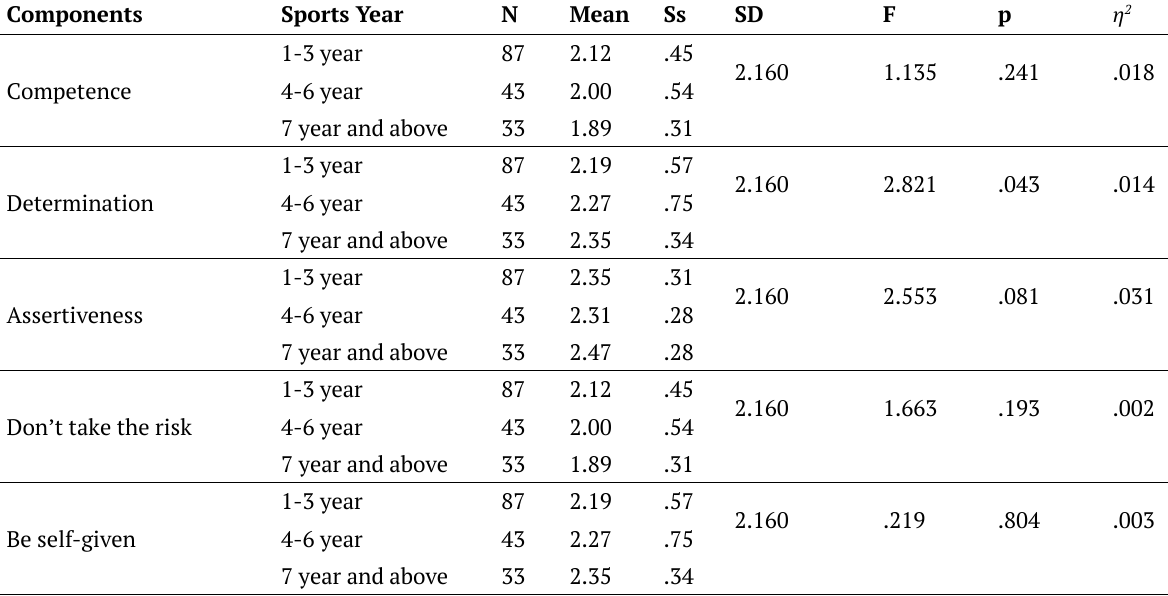
Table 3. ANOVA results of courage and sub-dimensions in sports according to the variable of years of doing sports